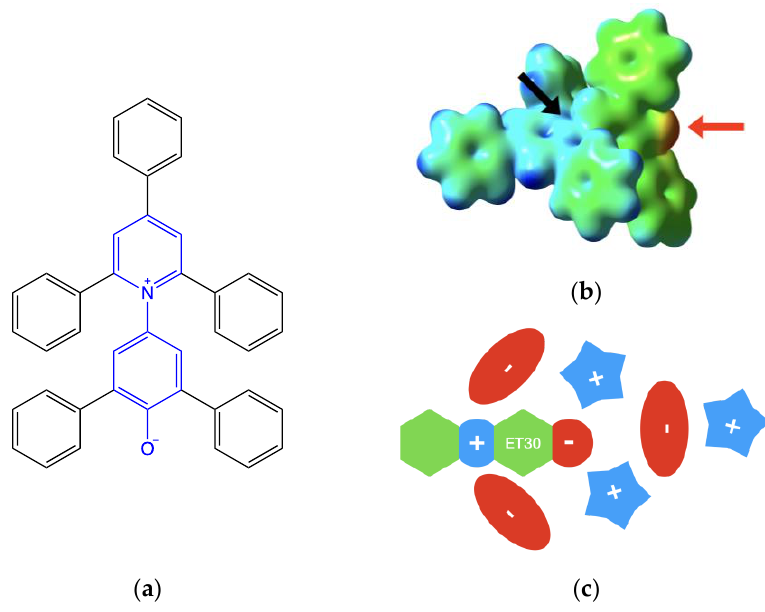
Figure 2. ( a ) Reichardt’s dye structure. The betaine core (in blue) presents five phenyl substituents. Steric hindrance does not allow the planarity of the molecule. ( b ) Isodensity map (threshold vale 0.01 a.u.) is mapped with the molecular electrostatic potential. False color scale goes from blue (electrophilic) to red (nucleophilic) while green (weak electrophilic) and yellow (weak nucleophilic) show regions with intermediate values. On the right is the phenate moiety (indicated by the red arrow). At the center is one of the sides of the pyridinium pocket (indicated by the black arrow). ( c ) Schematic representation is of the first solvation shell of Reichardt’s dye in ionic liquid.